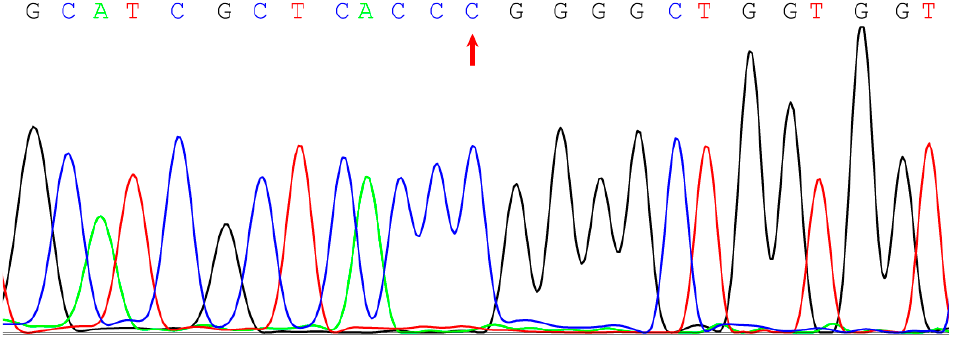
Figure 2. Sanger sequencing chromatogram for a sample with two copies of CES1A2 . The arrow shows rs2244613.